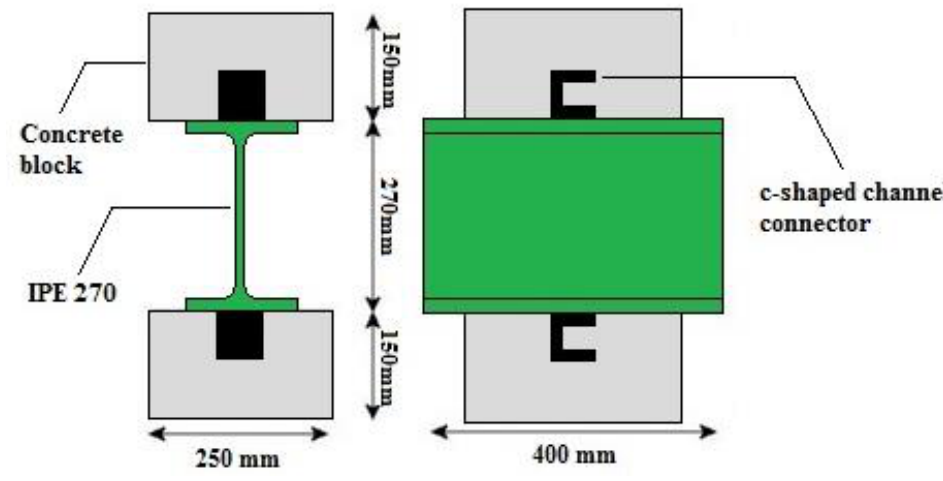
Figure 1. Schematic view of the test specimen.